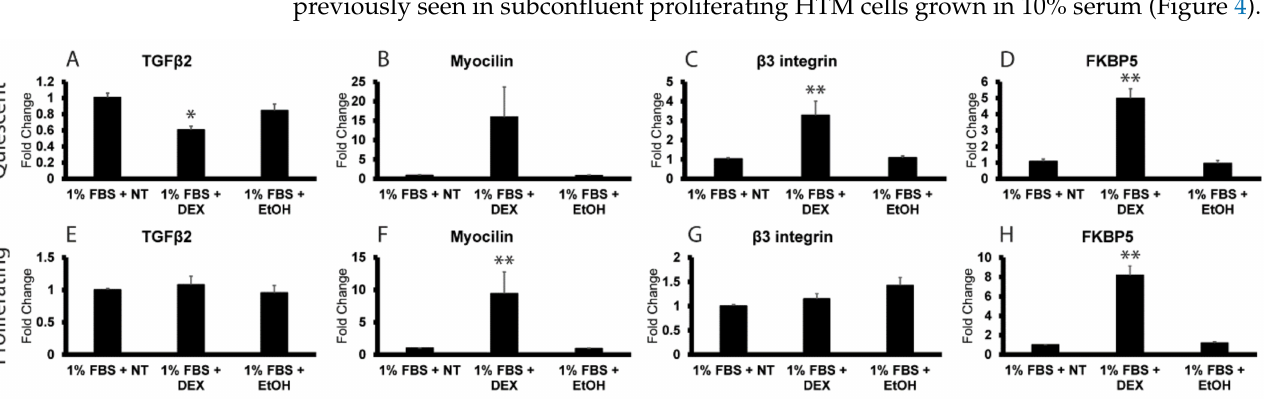
Figure 5. Serum starvation blocks DEX-induced expression of TGF β 2 and β 3 integrin in proliferating HTM cultures. RT-qPCR analysis was used to determine mRNA levels of TGF β 2, myocilin, β 3 integrin and FKBP5 in HTM cells. The names of the specific mRNAs analyzed are indicated above each panel. Panels ( A – D ) show 7-day post confluent cultures of HTM cells in 1% FBS that were left untreated (NT) or were treated with DEX or EtOH for 72 h. DEX increased myocilin, β 3 integrin and FKPB5, but not TGF β 2 mRNA in these cells. The increase in myocilin mRNA expression, however, was not quite statistically significant compared to controls ( p < 0.08). Panels ( E – H ) show that when subconfluent cultures of HTM cells in 1% FBS were left untreated (NT) or were treated with DEX or EtOH for 72 h, only mRNA levels for myocilin and FKBP5 were increased. The increases in TGF β 2 and β 3 integrin mRNA levels that were observed in the presence of 10% FBS (Figure 4) were abolished in the presence of 1% FBS. n = 4 (from 2 different cell strains). * p < 0.05; ** p <